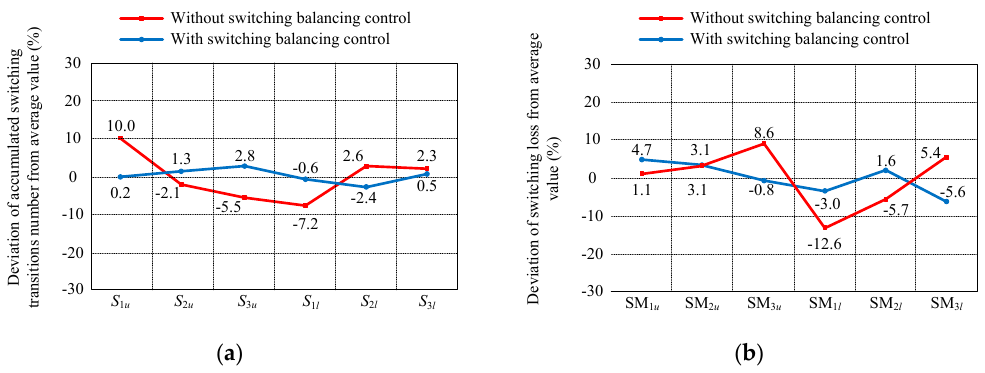
Figure 10. ( a ) Deviation of accumulated switching transition numbers from average value; ( b ) deviation of switching loss from average switching loss.